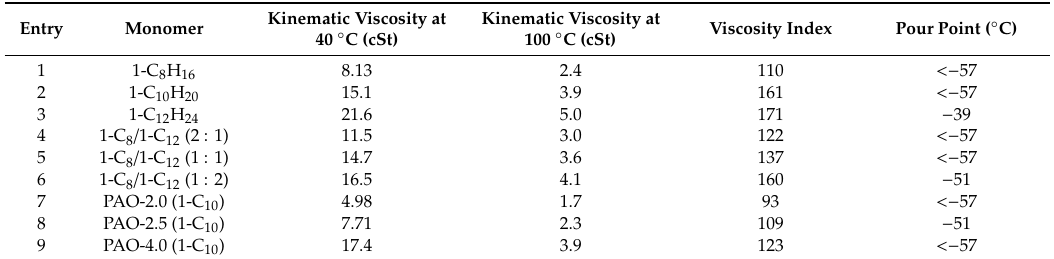
Table 1. Lubricant properties of prepared α -olefin trimers and commercial-grade poly( α -olefin)s